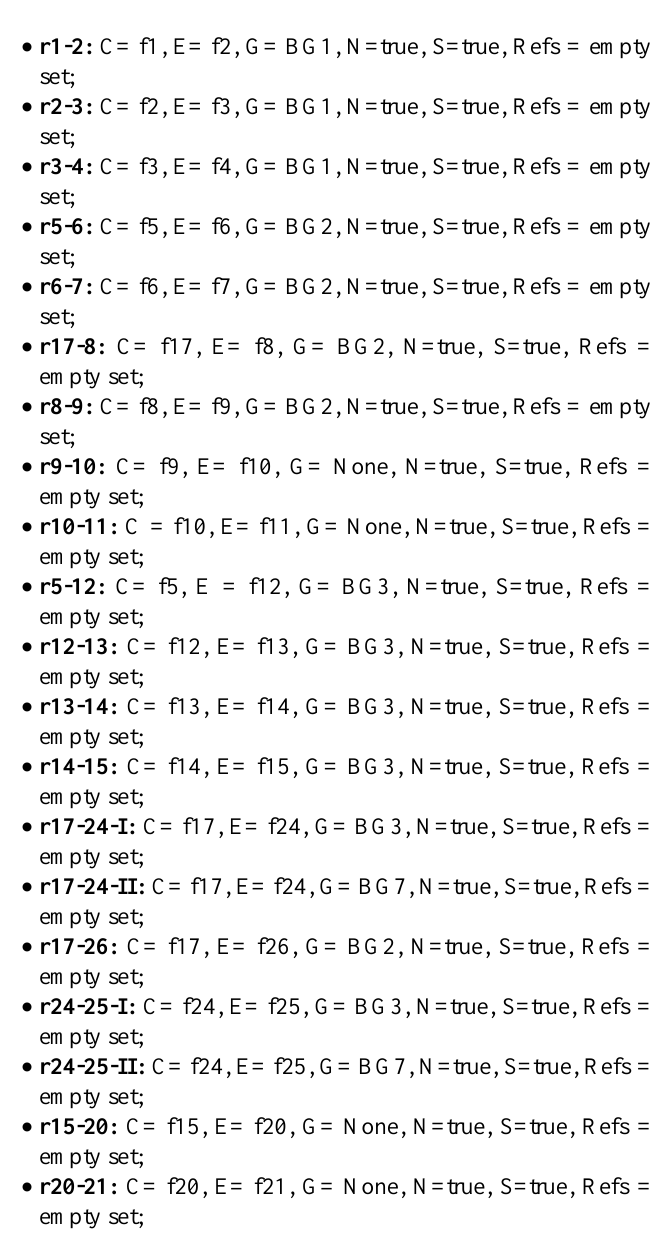
Fig. 2. The TFM of library functionality